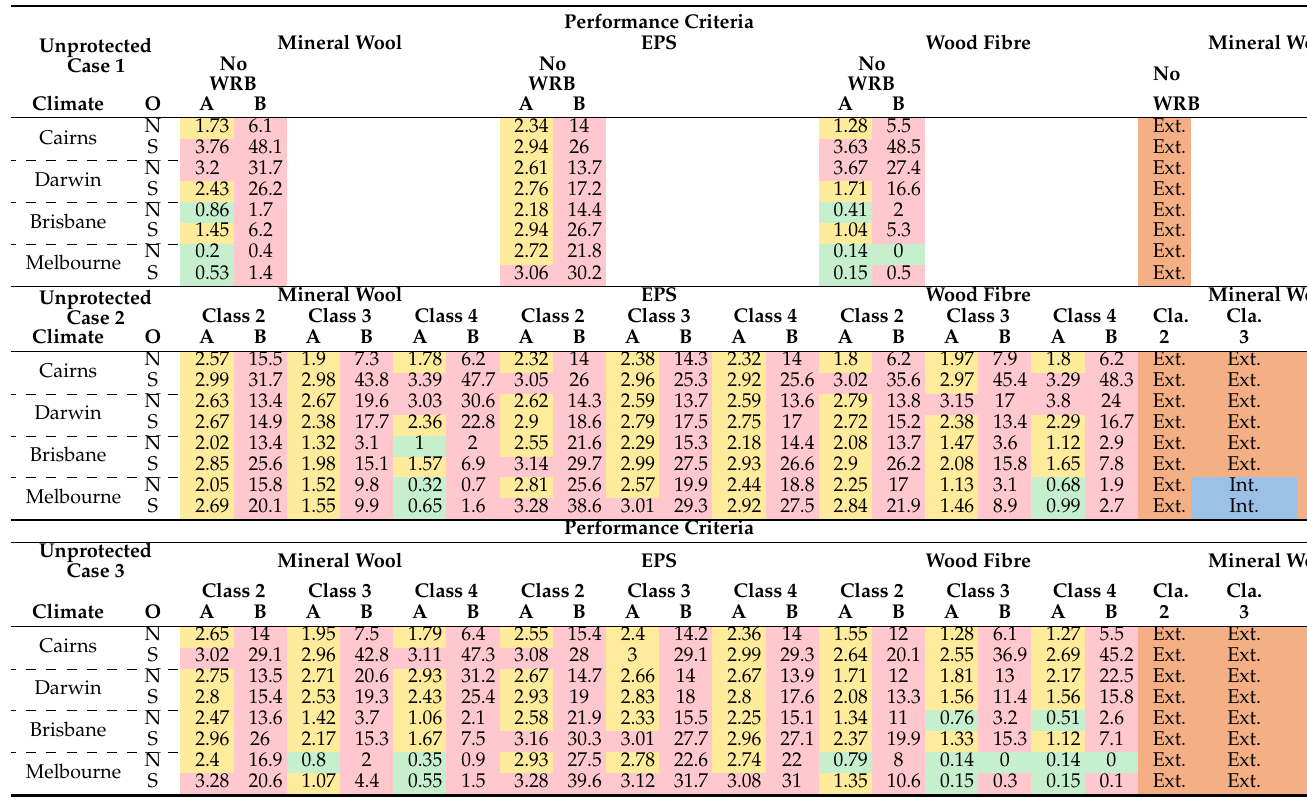
Table A4. Unprotected CLT results for external insulation. O (orientation). Performance criteria: A (mould growth index), B (corrosion rate). Classification of WRB: Class 2, 3, and 4 (vapour permeance). Green (pass), red (fail), or yellow (further investigation). Critical surface that fails the performance criteria indicated in right table: Ext. (external surface), Int. (internal surface), Both (both